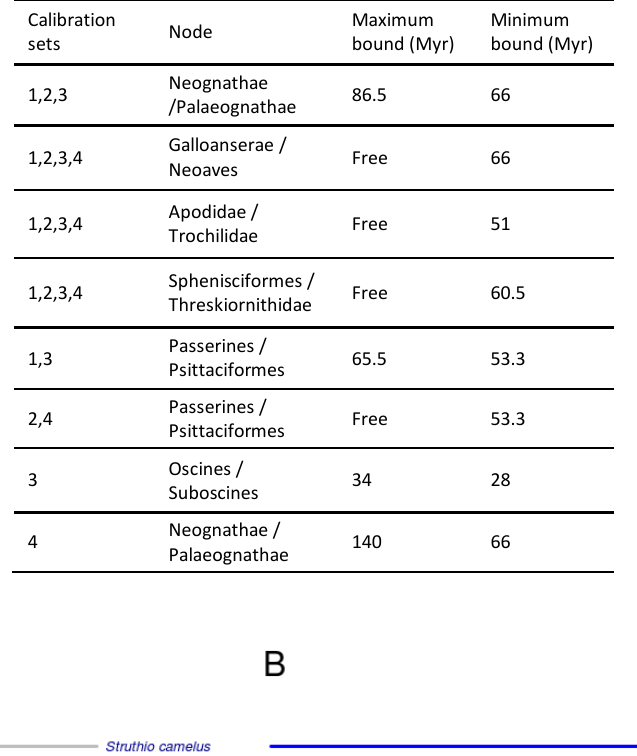
Table S3. Fossil calibration combinations used in the molecular dating analyses